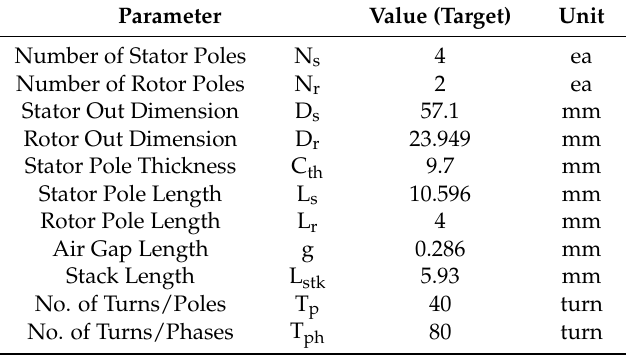
Table 2. Design parameter results of the proposed two-phase 4/2 pole